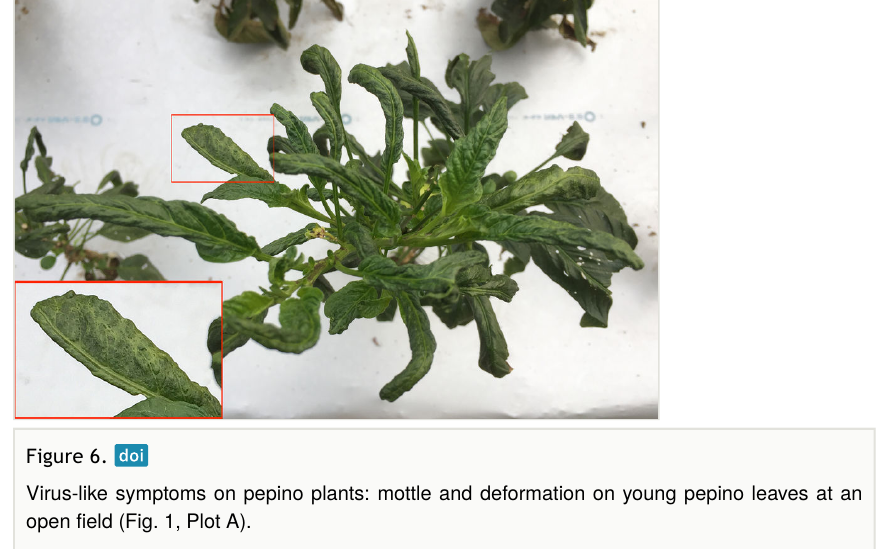
Figure 6. Virus-like symptoms on pepino plants: mottle and deformation on young pepino leaves at an open fi eld (Fig. 1, Plot